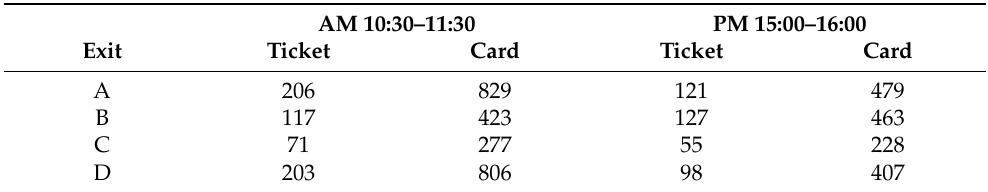
Table 1. Statistics on the behavior of pedestrians entering the subway station during one off-peak hour in the morning and the afternoon.